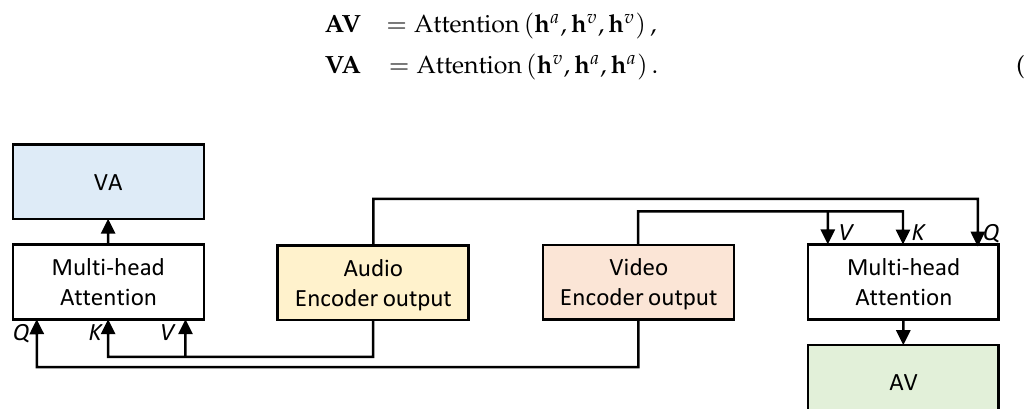
Figure 3. DCM attention architecture. Either audio or video encoder output as a query Q is fused with the other modality as a key K and a value V in a multi-head attention. AV and VA denote the audio query encoder and video query encoder outputs,